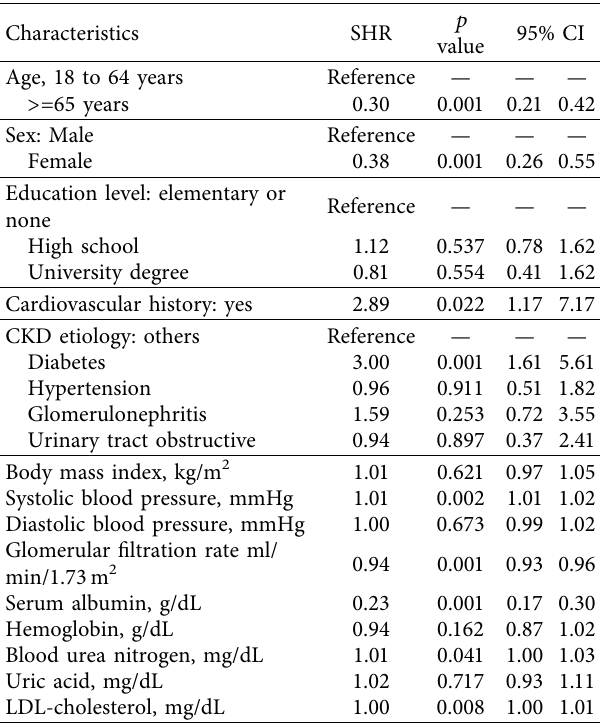
Figure 4: Transition probabilities between CKD stages by etiology. Transitions between CKD stages in 6-month intervals for the total population, diabetic, hypertensive, and glomerulonephritis populations are presented, e.g., on top left panel (total population) a patient in stage G5, after six months, has a 36.7% probability of starting dialysis, 53.2% of staying in stage G5 without dialysis, 8.2% of returning to stage G4, and so on. Table 3: Fine & Gray subdistribution hazard competing risk re- gression model for the dialysis initiation